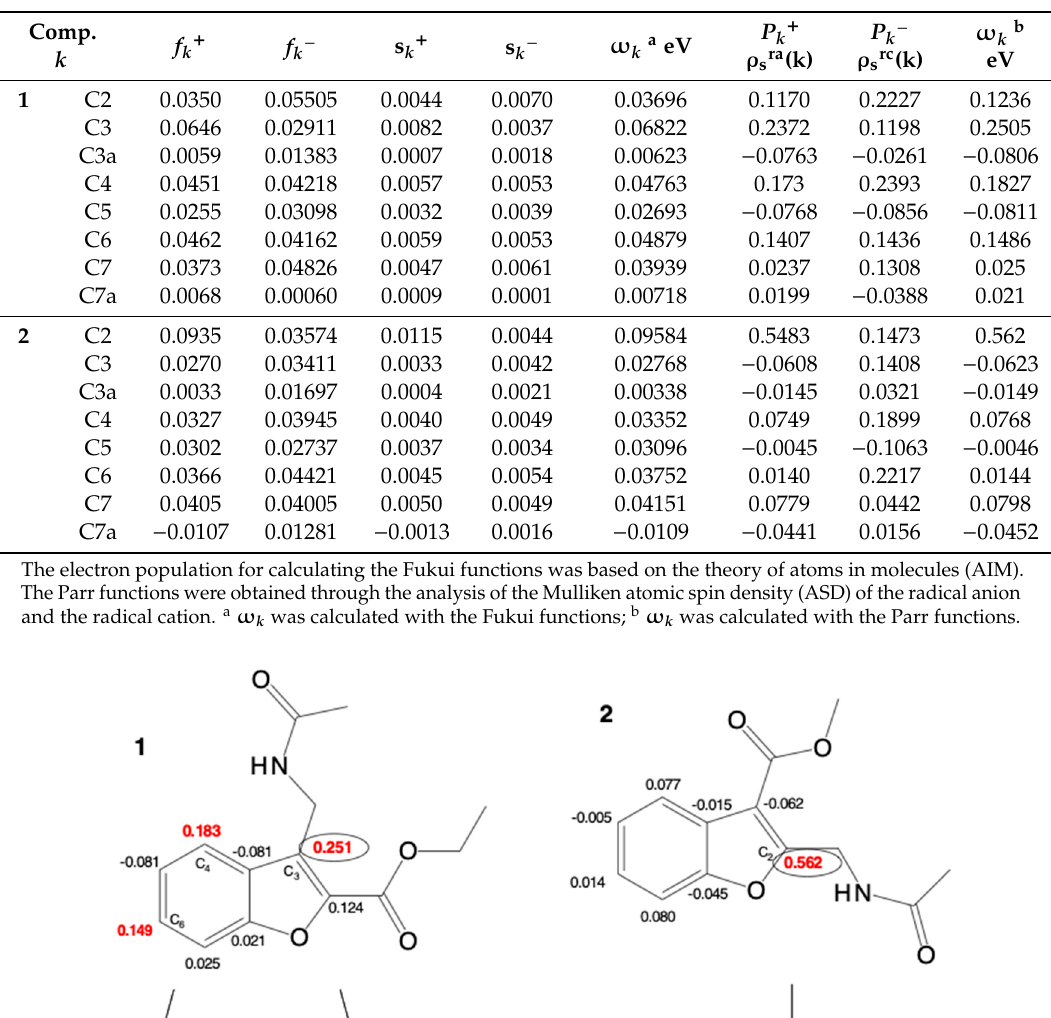
Table 4. The electrophilic ( f k + ) and nucleophilic ( f k − ) Fukui functions, as well as the electrophilic and nucleophilic local softness s k + and s k − , and the corresponding local electrophilicity index ω k a at di ff erent positions in the compound. Also presented are the electrophilic ( P k + ) and nucleophilic ( P k − ) Parr functions, and the corresponding local electrophilicity index redefined as ω k b .